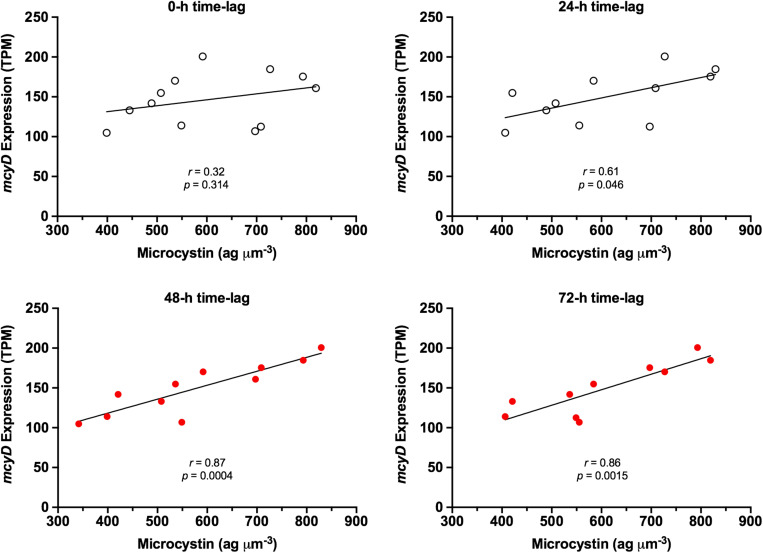
Time-lag effect on correlation between mcyD expression and normalized cellular microcystin content. Red dots represent time-lag periods with high correlation and significant p-value.